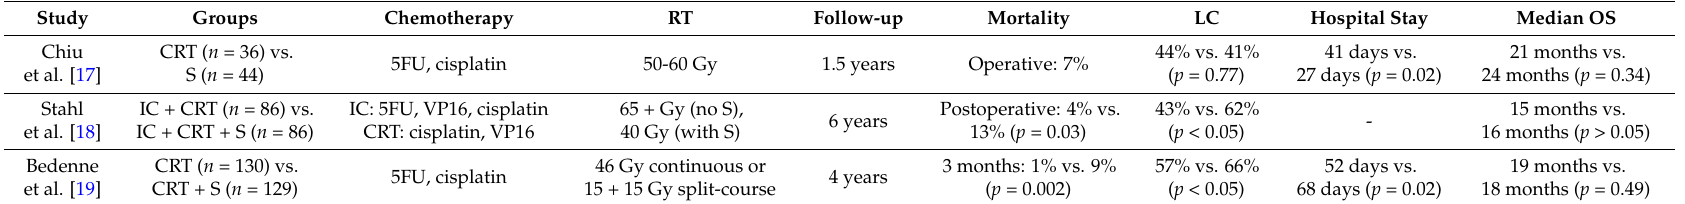
Table 2. Randomized evidence comparing chemoradiation and